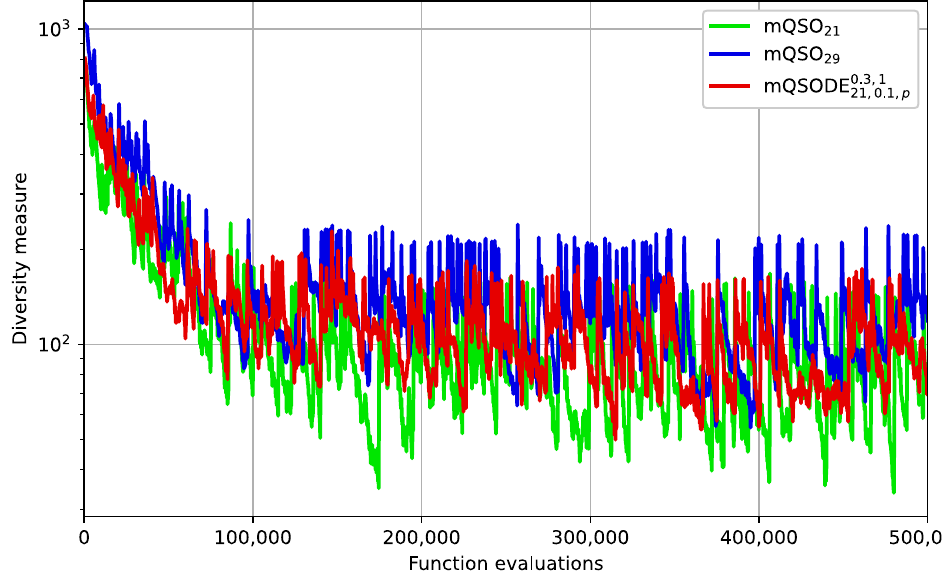
Figure 4. Diversity measures of mQSO 21 , mQSO 29 and mQSODE 21,0.1,p , setting 1.